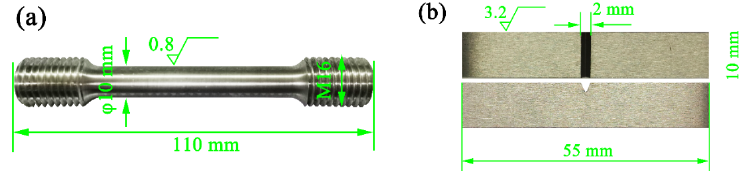
Figure 1. Mechanical test samples pictures: ( a ) Tensile tensile tests; ( b ) impact tensile tests. The SEM and EBSD samples were 5 mm thick, 10 mm long and 10 mm wide. After grinding and polishing, the samples were electrolytically polished in a mixed solution of